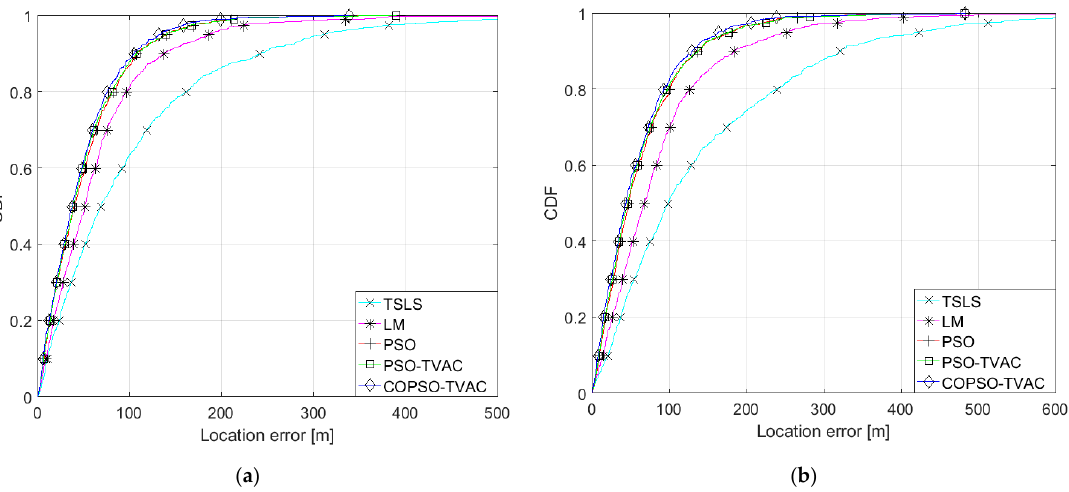
Figure 6. CDF of the location error in the scenario with 3 NLOS BSs: ( a ) the suburban environment; ( b ) the urban environment.